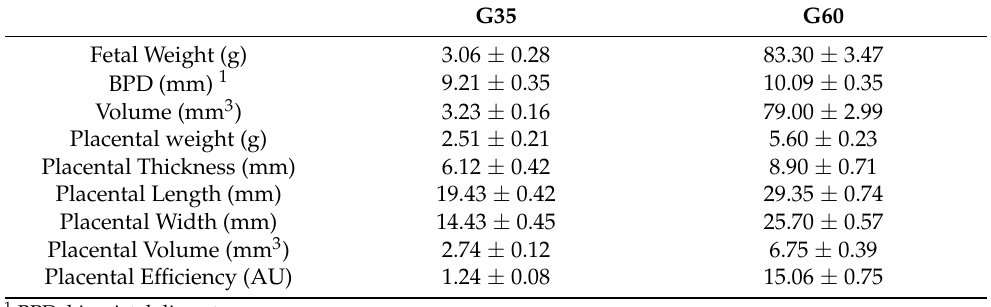
Table 2. Fetal and placental biometry at euthanasia.